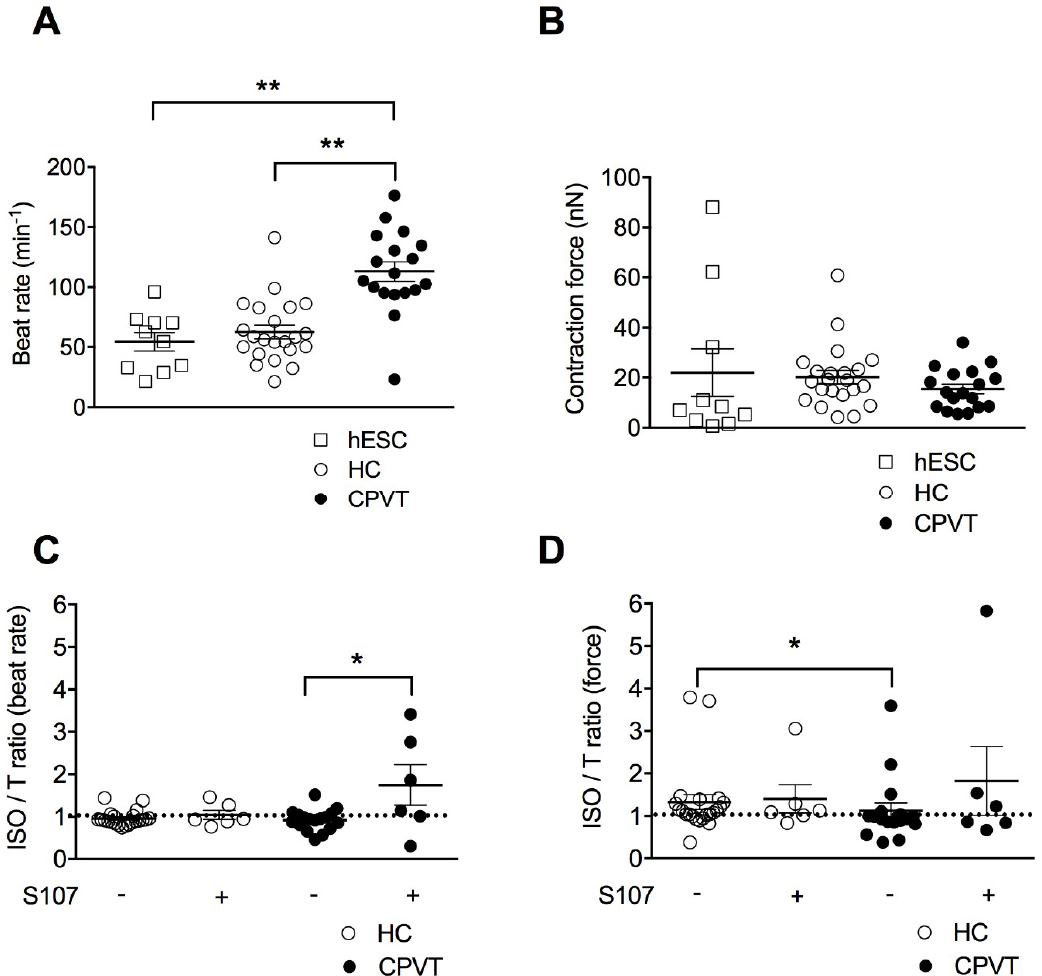
Figure 2. Contractile properties of CPVT human induced pluripotent stem cell-derived embryoid bodies (hiPSC-EBs). ( A ) Scatter plots showing beat rates for control human embryonic stem cell hESC-EBs (hESC), healthy control-EBs (HC) and CPVT-EBs (C2.2, CPVT) at rest. ( B ) Contraction force for hESC-, HC- and CPVT-EBs at rest. ( C ) Ratio of beat rates under 1 µ M ISO to beat rates at rest for HC and CPVT ± (indicated by the + or − symbols) 5 µ M S107 (overnight). ( D ) Ratio of contraction forces under 1 µ M isoproterenol (ISO) to contraction forces at rest for HC and CPVT ± (indicated by the + or − symbols) 5 µ M S107 (overnight). The dotted line indicates the ratio threshold. The number of experiments varies from 6 to 22 for each scatter plot. Data are presented with mean ± SEM. * p < 0.05; ** p < 0.01.